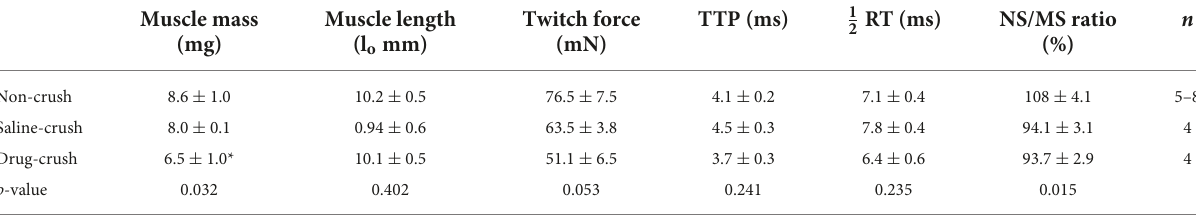
TABLE 1 Electrophysiological assessment of soleus mass, length, and force